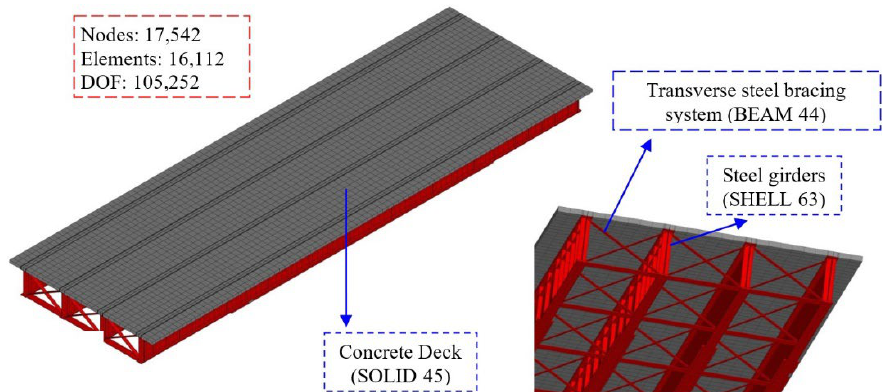
Figure 6. Finite element model of the roadway bridge.